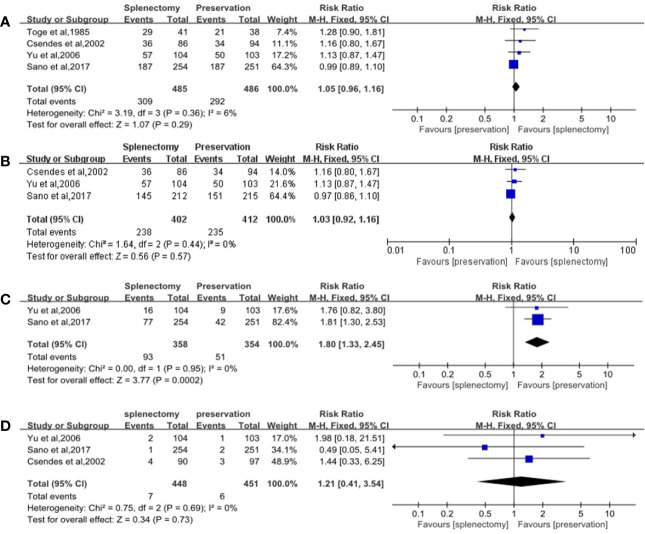
Forest plots of overall survival rates and safeties. (A) Forest plot of 5-year overall survival rate for all cases, with 95%CI. Data for a fixed-effects model are shown as there was no statistical heterogeneity; (B) Forest plot of 5-year overall survival rate for cases with proximal and whole gastric carcinoma, with 95%CI. Data for a fixed-effects model are shown as there was no statistical heterogeneity; (C) Forest plot of postoperative morbidity, with 95%CI. Data for a fixed-effects model are shown as there was no statistical heterogeneity; (D) Forest plot of postoperative mortality, with 95%CI. Data for a fixed-effects model are shown as there was no statistical heterogeneity.